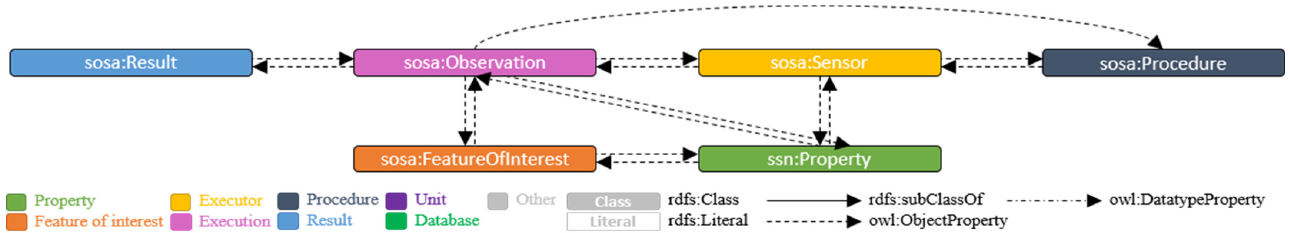
Figure 5. SSN/SOSA’s pattern to describe dynamic properties measured by sensor observations. Kuster et al. [84] extended SSN to the urban scale in their UDSA ontology. They added a spatial component to both the sensor and the observation to describe the location of the sensor and the region for which the observation is valid. Unfortunately, UDSA integrates an outdated version of